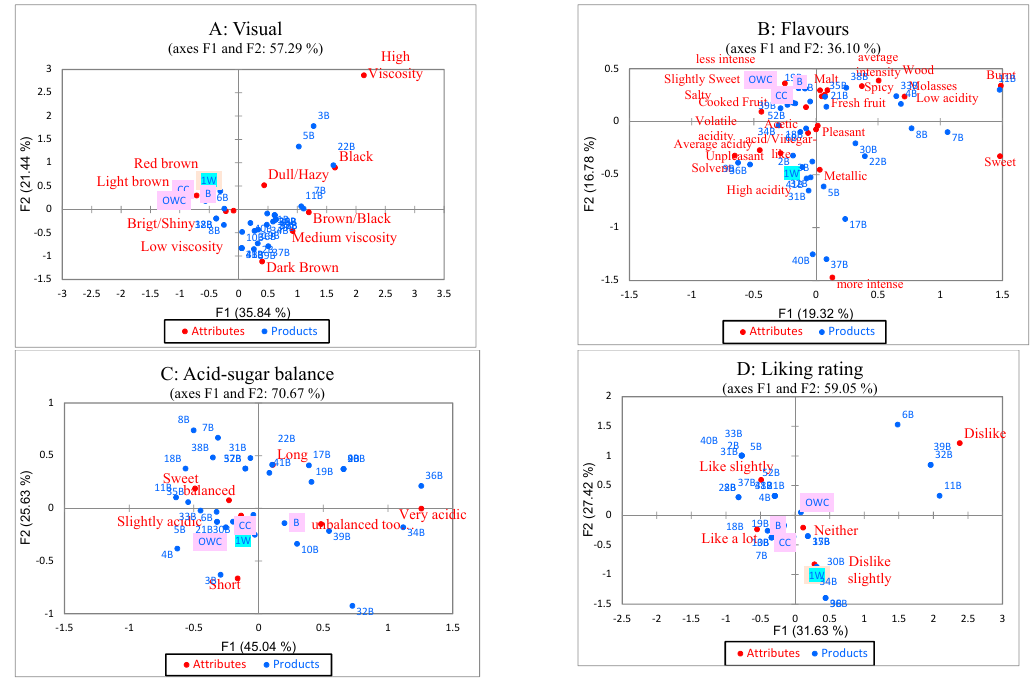
Figure 7. Correspondence analysis of CATA (check all that apply) sensory data for three BSV and 29 commercial balsamic vinegars (blue). ( A ) Visual, ( B ) Flavors, ( C ) Acid–sugar balance, ( D ) Consumer acceptance/liking rating. All BSV samples were shaded purple (CC: corncobs, OWC: oakwood chips, B: beads), with one wine vinegar being shaded light blue (1W: wine vinegar).